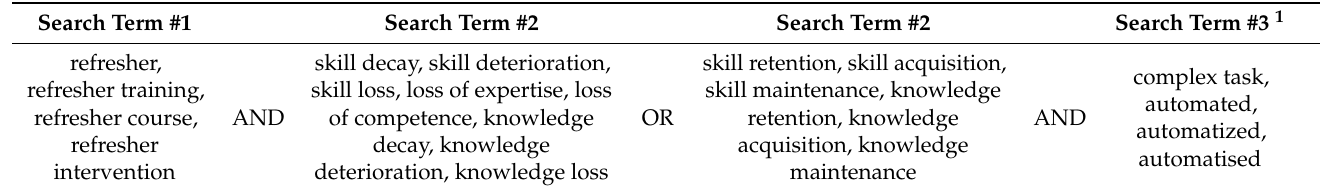
Table 1. Search terms used for the systematic literature search in Google Scholar, Web of Science, and EBSCOhost.